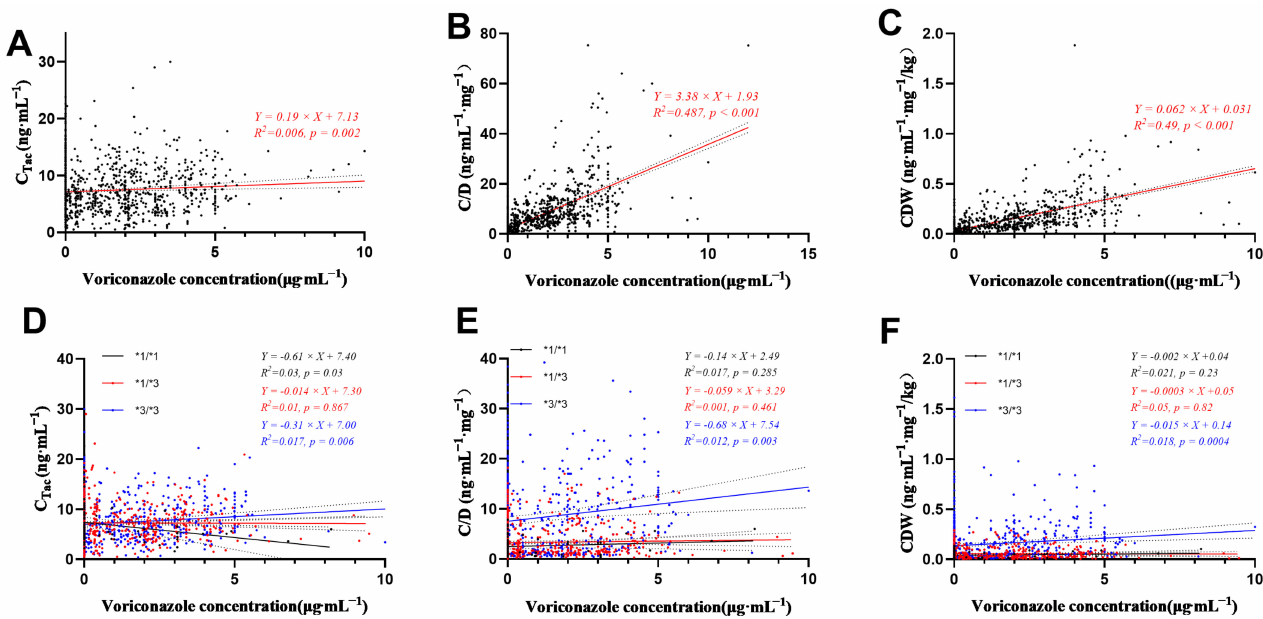
Figure 4. Linear regression of voriconazole concentration with C Tac ( A ), C/D ( B ), and CDW ( C ) and stratified regression of voriconazole concentration (C VRC ) with C Tac ( D ), C/D ( E ), and CDW ( F ) in different CYP3A5 genotype groups. In ( D – F ), black line and dots represent the regression line and values in groups with genotype of CYP3A5*1/*1; blue line and dots represent the regression line and values in groups with genotype of CYP3A5*3/*3; red line and dots represent the regression line and values in groups with genotype of